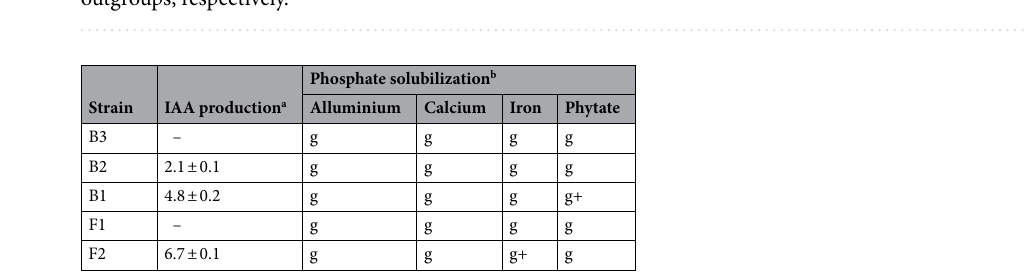
Table 1. IAA production and phosphate solubilization by microbial endophytes isolated from C. limon seeds. a Reported as µg/µL of IAA equivalents, − no production. b g growth, + clearance halo.